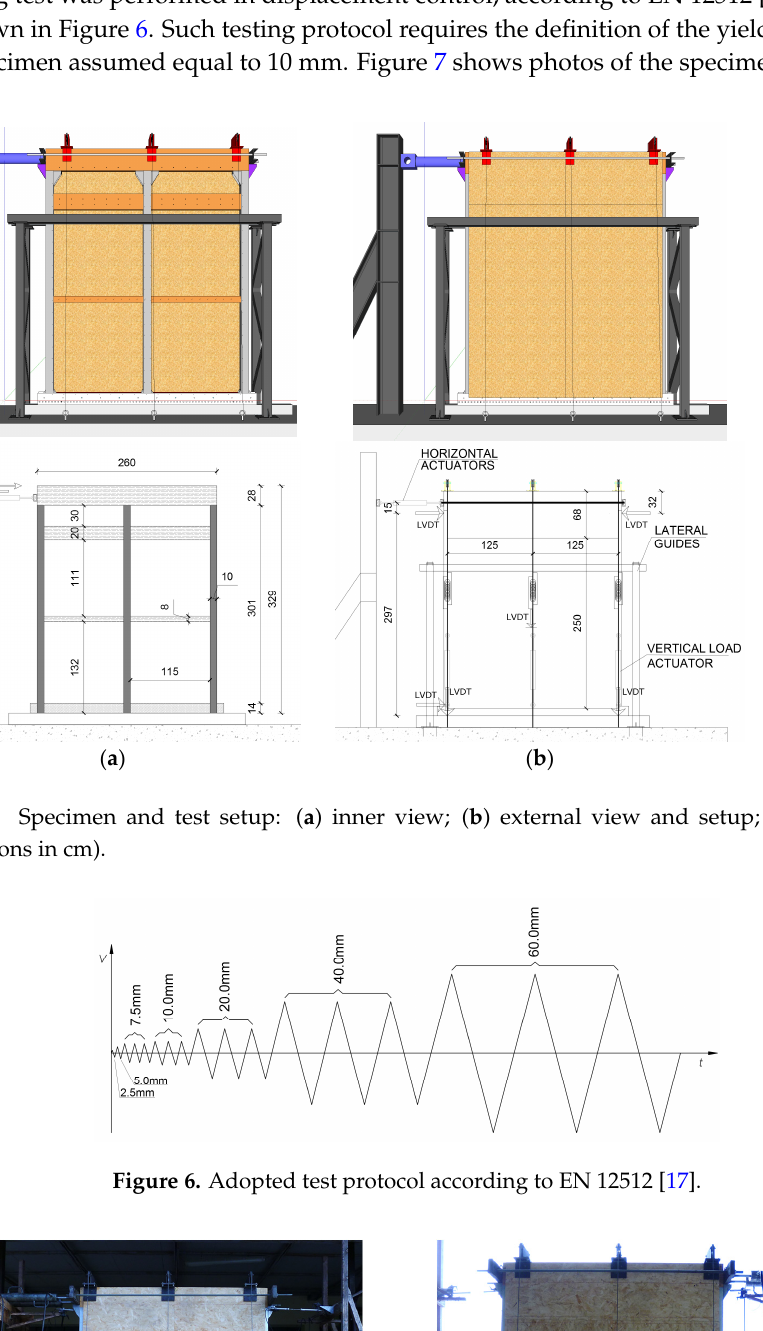
( b ) Figure 8. ( a ) Force vs. top displacement curve; ( b ) deformed specimen at 60 mm cycles. The response of the shear wall was characterized by ductile failures localized in the steel ‐ to ‐ timber screws and the timber ‐ to ‐ timber nails. These fasteners behaved according to the preliminary tests described in Section 3, allowing appreciable relative slip among panels, as shown in Figure 9a,b. However, for higher displacements some brittle failures occurred at the base of the steel column consisting in withdrawal of OSB ‐ to ‐ column screws, localized buckling phenomena of the steel section at the base and screw head penetration (Figure 9c,d). ‐ 4.00% ‐ 3.00% ‐ 2.00% ‐ 1.00% 0.00% 1.00% 2.00% 3.00% 4.00% ‐ 100 ‐ 75 ‐ 50 ‐ 250255075100 ‐ 120 ‐ 100 ‐ 80 ‐ 60 ‐ 40 ‐ 20